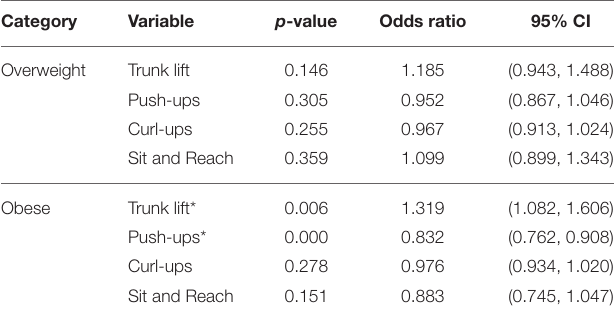
TABLE 9A | Associations between musculoskeletal fitness and weight status in kindergarten through second grades (reference group: healthy weight). Category